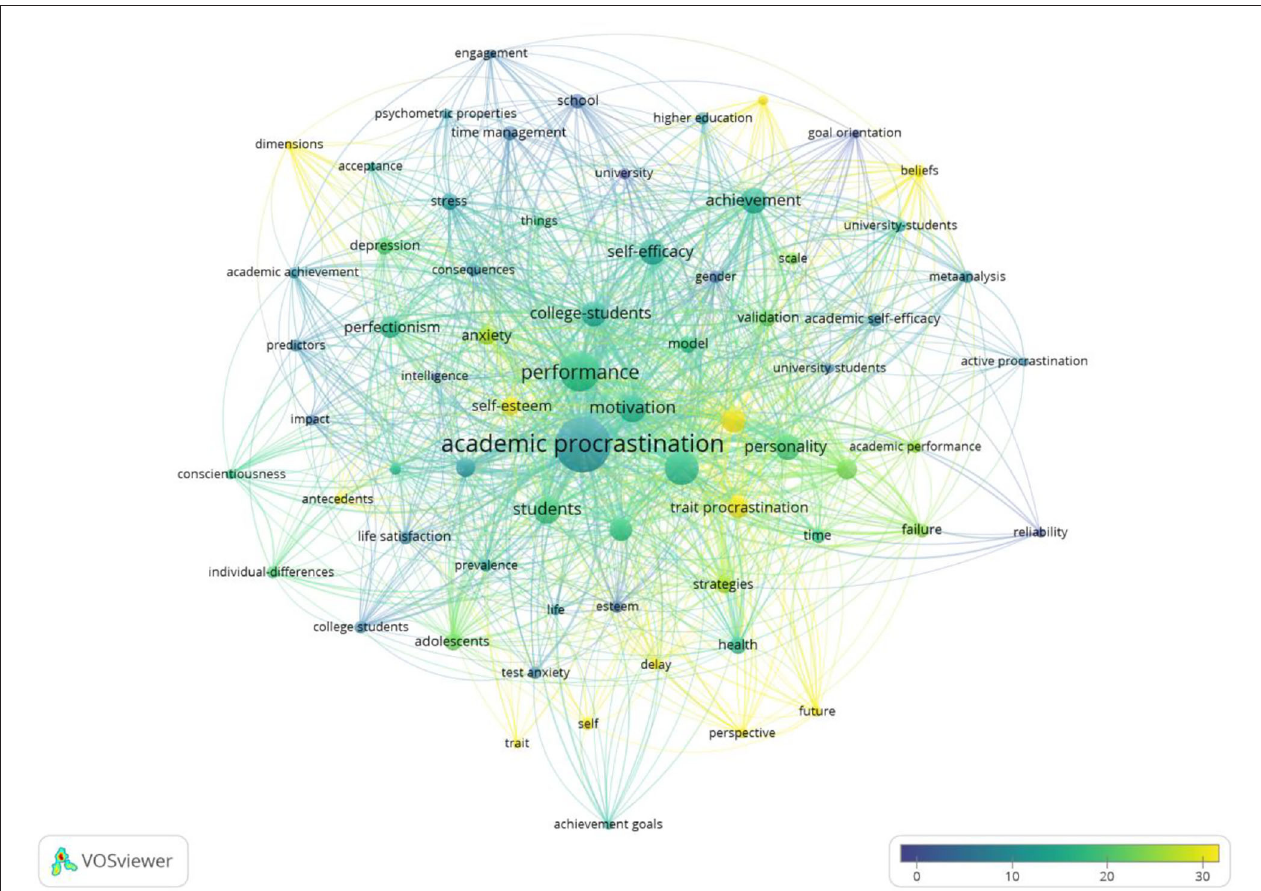
FIGURE 8 | Overlay visualization based on academic procrastination link-weights and citation